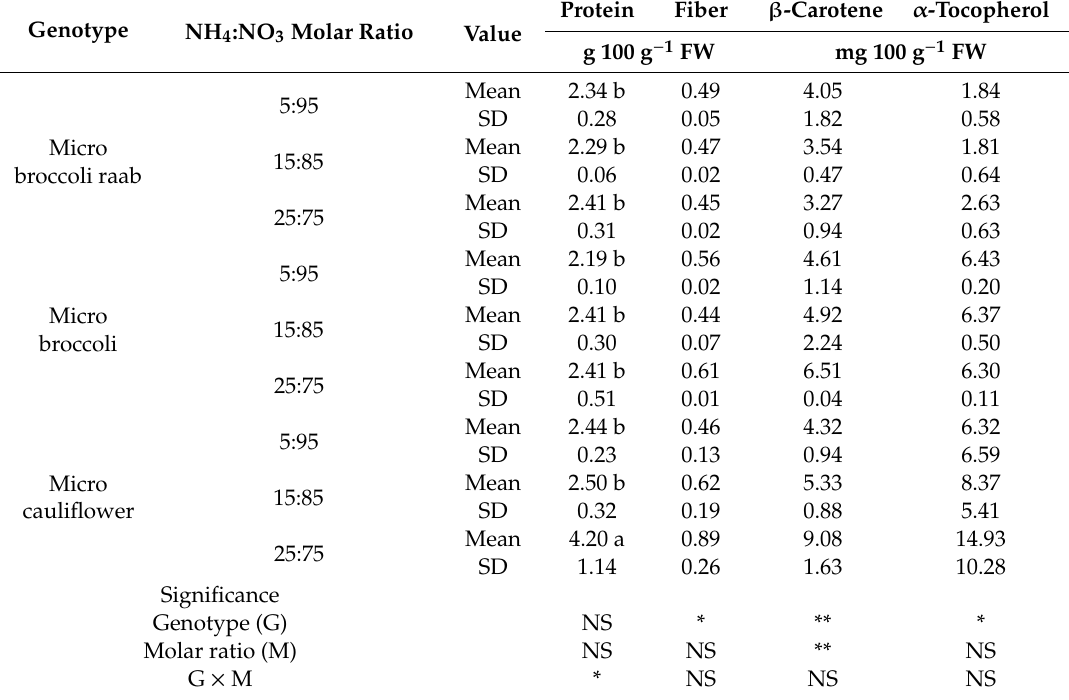
Table 2. Content of protein, fiber, β -carotene and α -tocopherol in Brassica microgreens grown by using a nutrient solution with three NH 4 :NO 3 molar